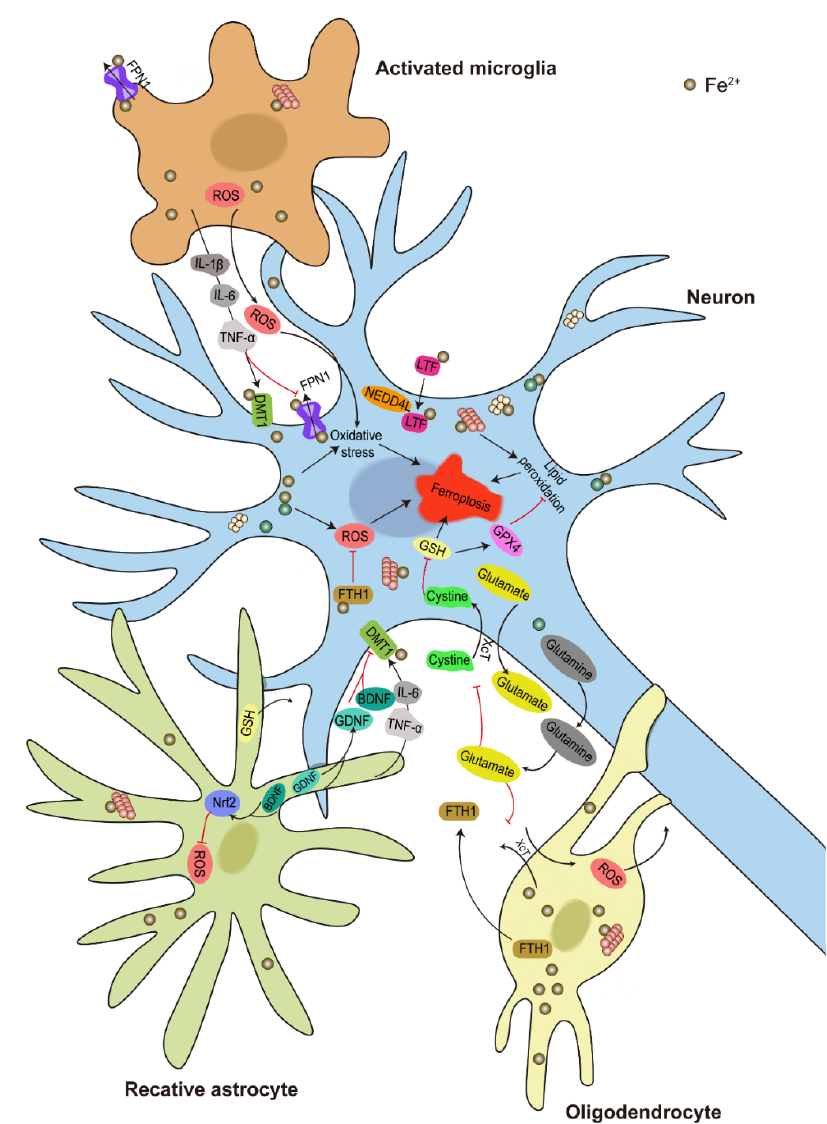
Figure 4. Glial activation in regulating DA neuron ferroptosis. Iron binding could enhance α -syn aggregation by generating conformational changes in neuron. Many genes have been involved in regulating ferroptosis. NEDD4L inhibits intracellular iron accumulation and ferroptosis through binding and degrades lactotransferrin (LTF). Glutathione peroxidase 4 (GPX4) suppresses lipid peroxidation and this requires GSH. The glutamine secreted from neurons can be converted into glutamate and increase extracellular glutamate content, which in turn inhibits XcT function and results in ferroptosis. All three types of glia could regulate DA neuron ferroptosis, in either promoting or inhibiting ways. Iron accumulation induces microglia activation, activated microglia promote pro-inflammatory factors release such as TNF- α, IL -6, IL- 1β, and ROS production, all of which contributes to DA neuronal death. Inflammatory cytokines produced by active microglia and astrocytes could upregulate Divalent metal transporter 1 (DMT1) and downregulate ferroportin1 (FPN1), resulting in iron accumulation in neurons. Astrocytes can help to prevent iron overload in neurons, disruptions in astrocyte ‒ neuron connections and insufficient Nrf2 activation may result in ferroptosis in neurons. Astrocytes transmit extra GSH to the neuronal region, replenishing the antioxidant dysfunction in neurons during ferroptosis. Active astrocytes also release BDNF and GDNF to inhibited iron uptake by reducing DMT1 expression. Astrocytes and oligodendrocytes regulate glutamate levels in the synaptic cleft by regulating GSH production and suppressing neuronal XcT. Oligodendrocytes secrete FTH1 into the extracellular space to protect neurons from oxidative injury.